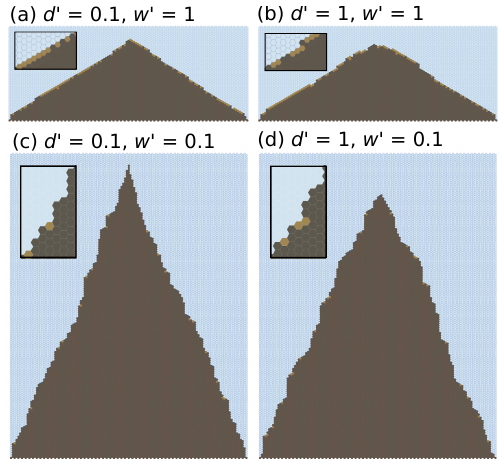
Figure 16. Quasi-steady model hillslope profiles created using a collapse rule, under four different combinations of d (cid:48) and w (cid:48) . Insets show magnified views of a portion of each